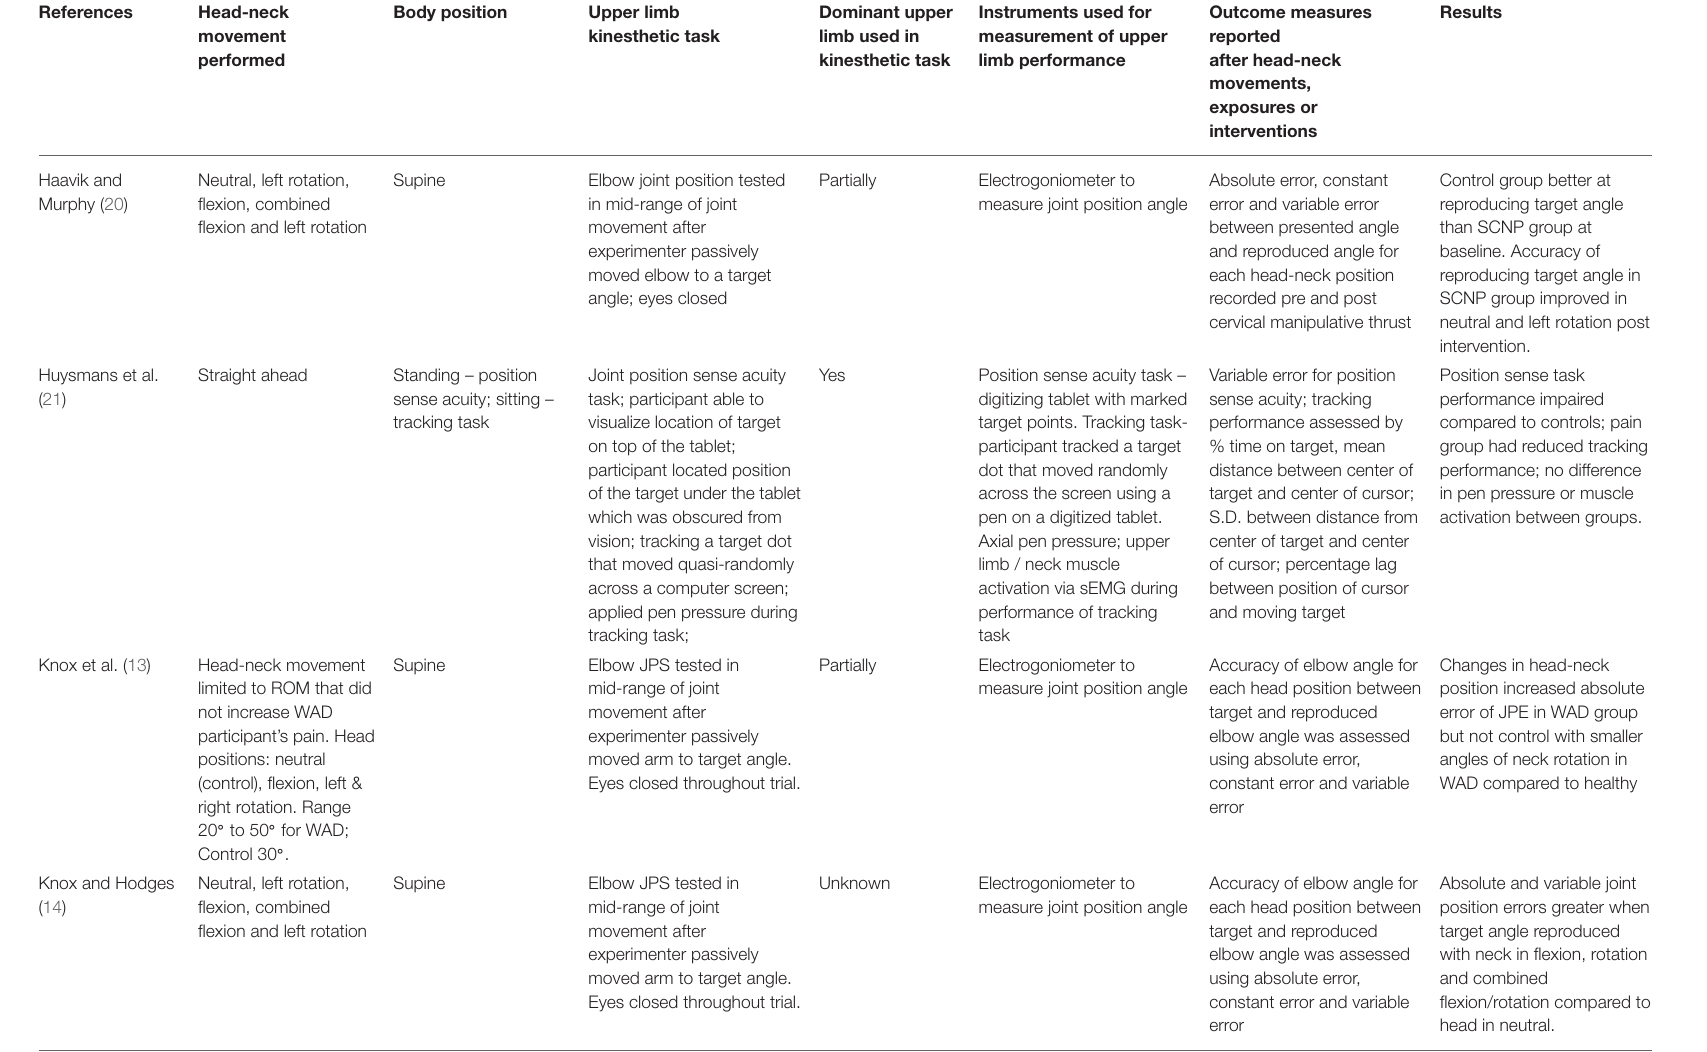
TABLE 4 | Association between the neck and changes in accuracy in completion of upper limb sensorimotor